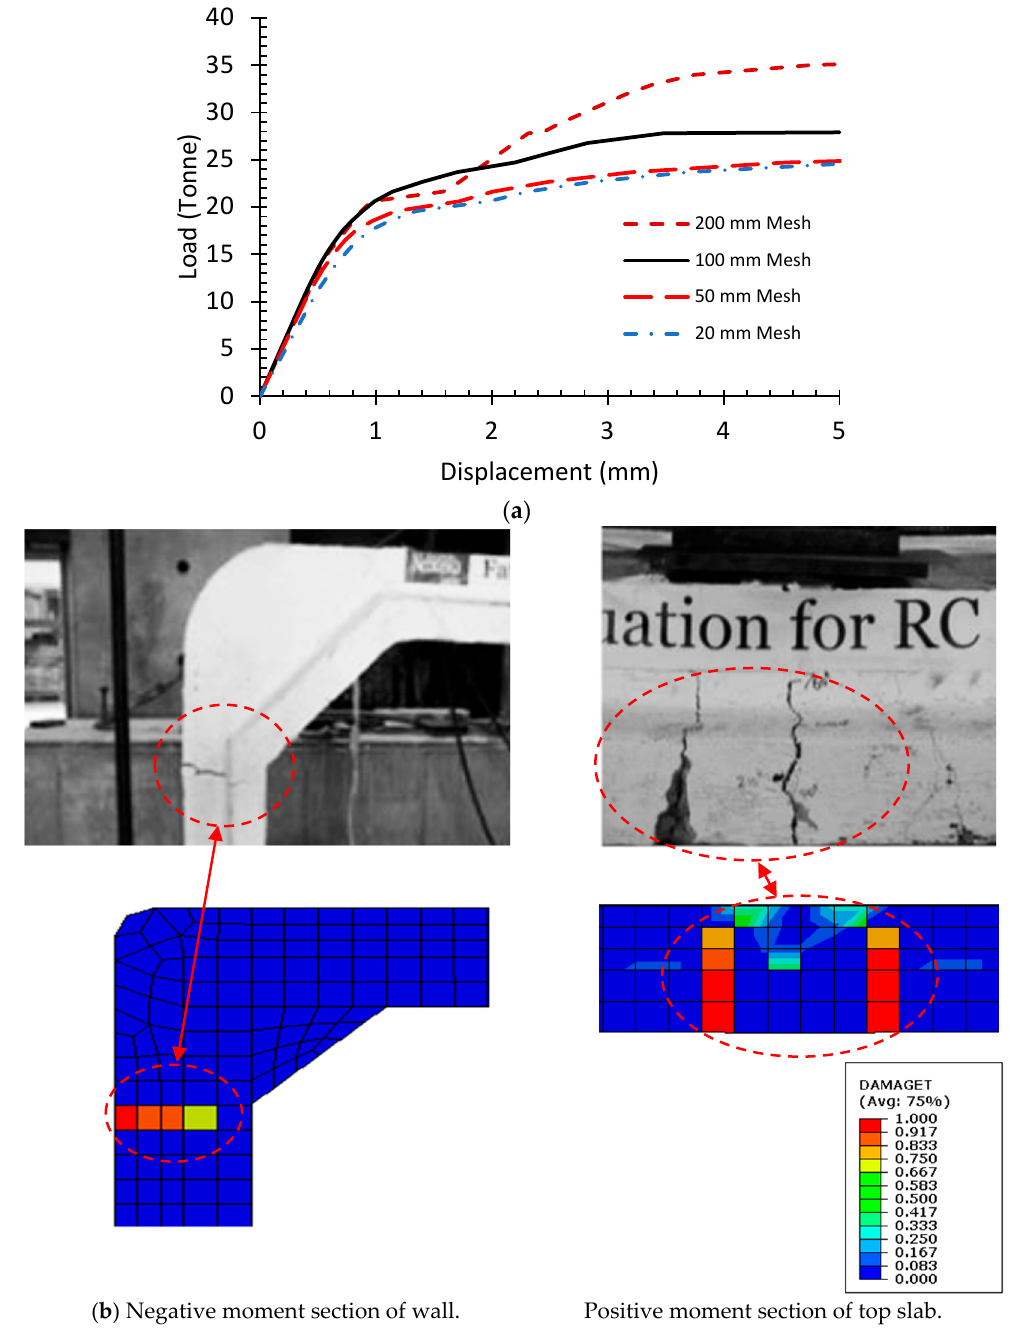
( b ) Negative moment section of wall. Positive moment section of top slab. Figure 7. ( a ) Performance of numerical model with different mesh sizes and ( b ) crack patterns observed in the experiment of Maximos et al. [18] (image used with the permission of publisher). Table 3. Results of model calibration.